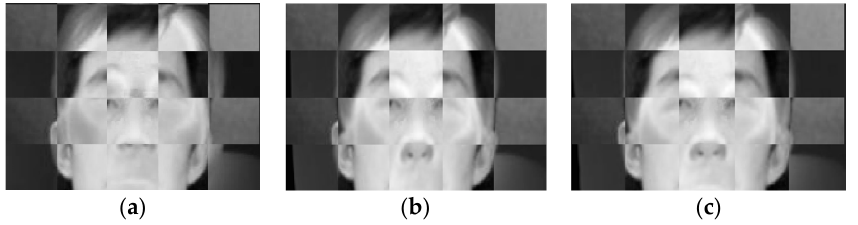
Figure 5. Edge map pairs view of registered visible (green) and IR (red) images with the ( a ) coarse, ( b ) coarse-Demons, and ( c ) coarse-spline methods.